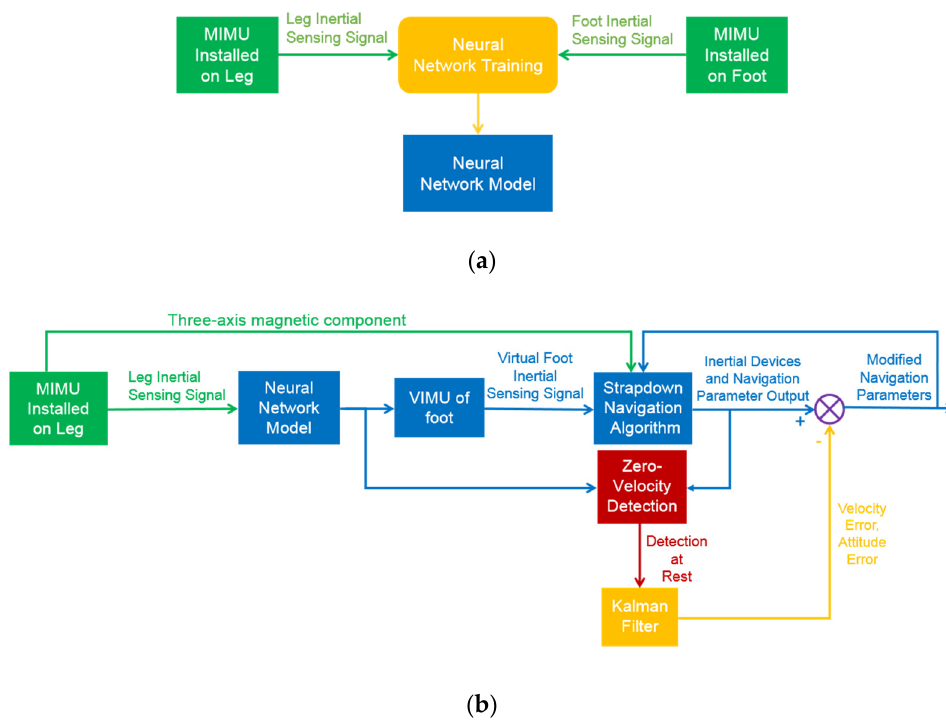
Figure 1. The overall scheme of pedestrian navigation method ( a ) Construction of neural network; ( b ) Diagram of the pedestrian navigation process.